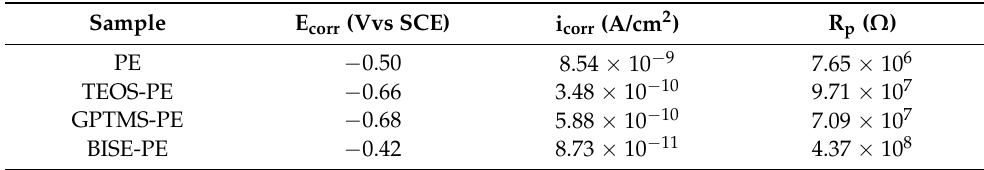
Figure 2. The extrapolation of linear Tafel segments of the cathodic curve. Table 2. Corrosion dynamics parameters of